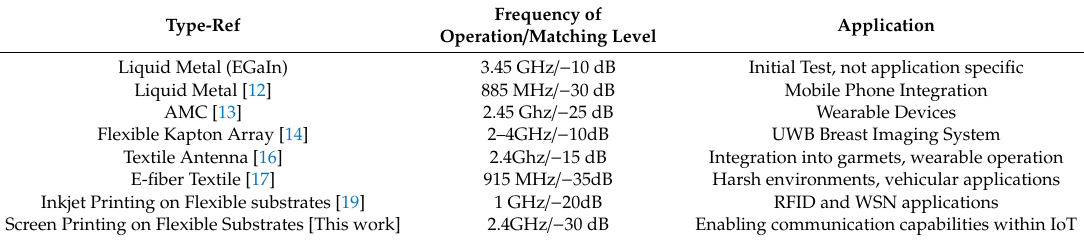
Table 4. Comparison of radiating